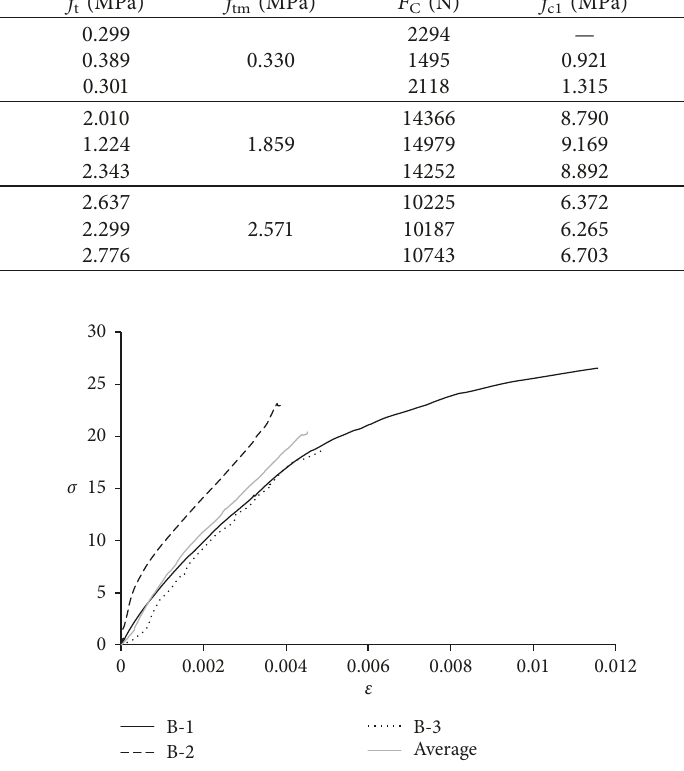
Figure 1: Diagram of σ - ε of compressive tests on bricks. Table 2: Maximum load ( F i ,max ) and the related shear strength ( f v0, i ) for each triplet and average value ( f v0